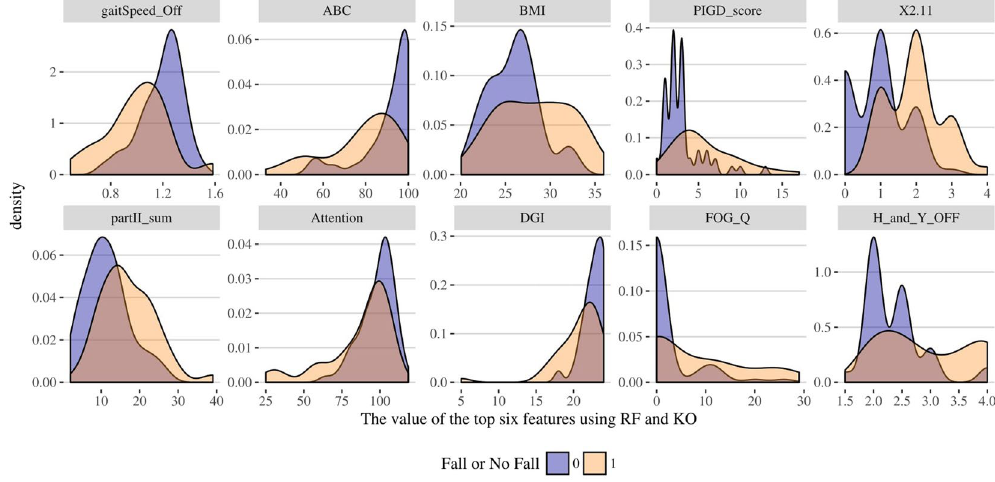
Figure 11. Density plots showing that the top 10 selected clinical features have significantly different distributions between falls and no-fall patient groups.